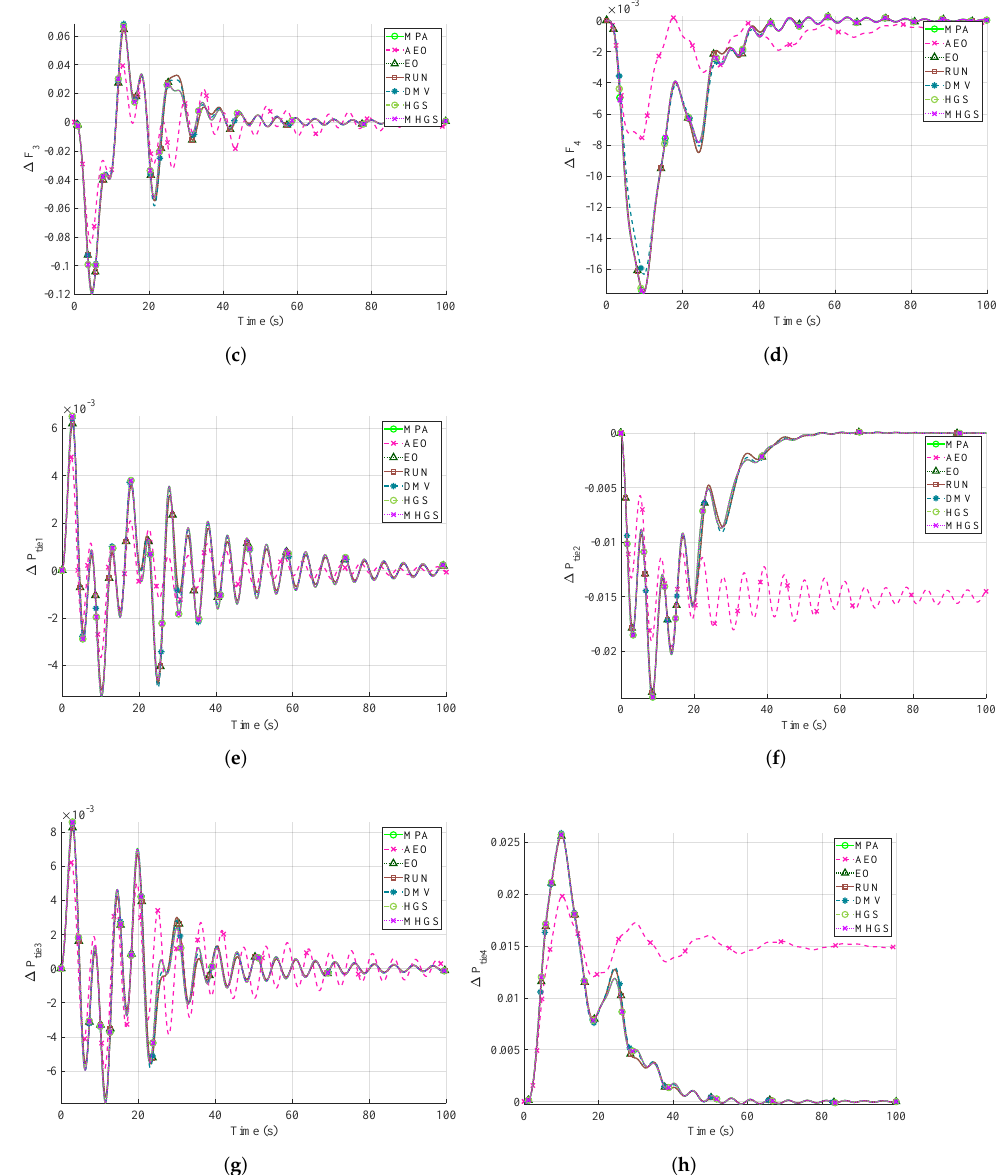
Figure 16. Time responses of 1% load disturbance applied on area 2 of multi-interconnected area